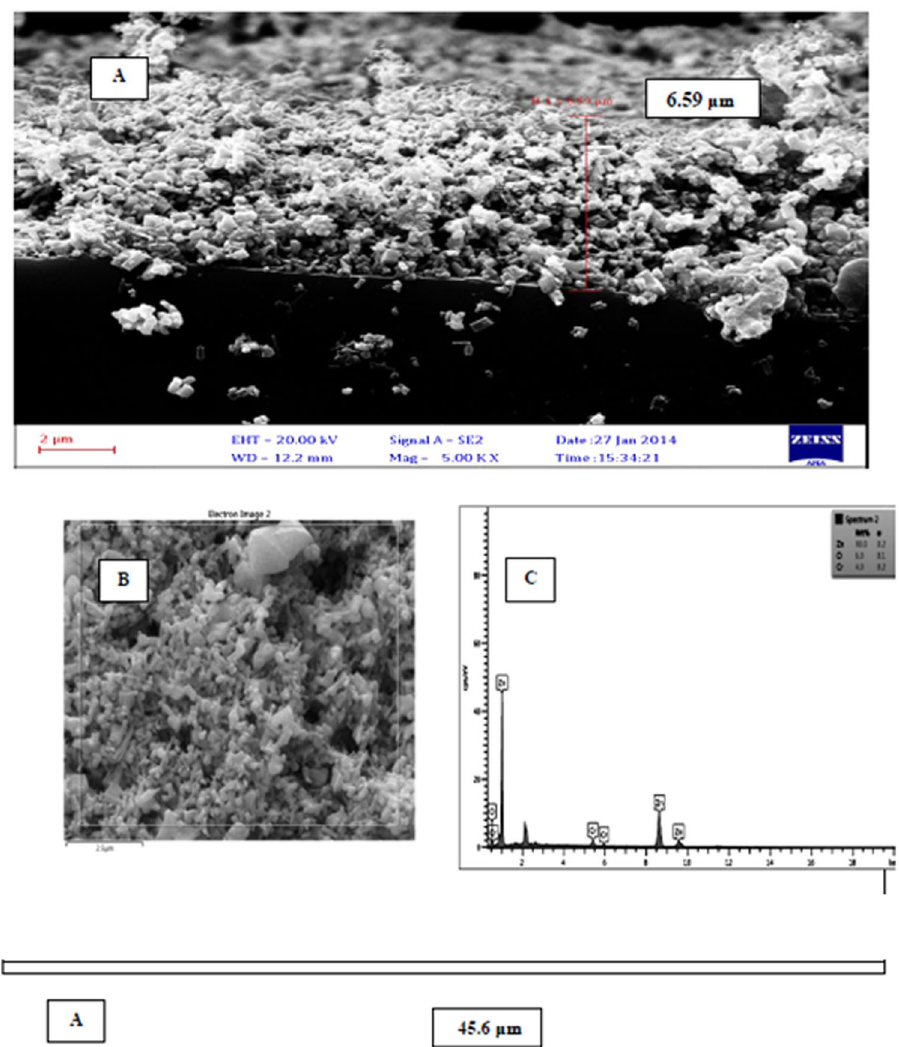
Figure 5. ( A ) Cross sectional SEM image; ( B ) Surface based SEM image; ( C ) EDX diagram based on a layer of doped zinc oxide nanoparticles immobilized on glass